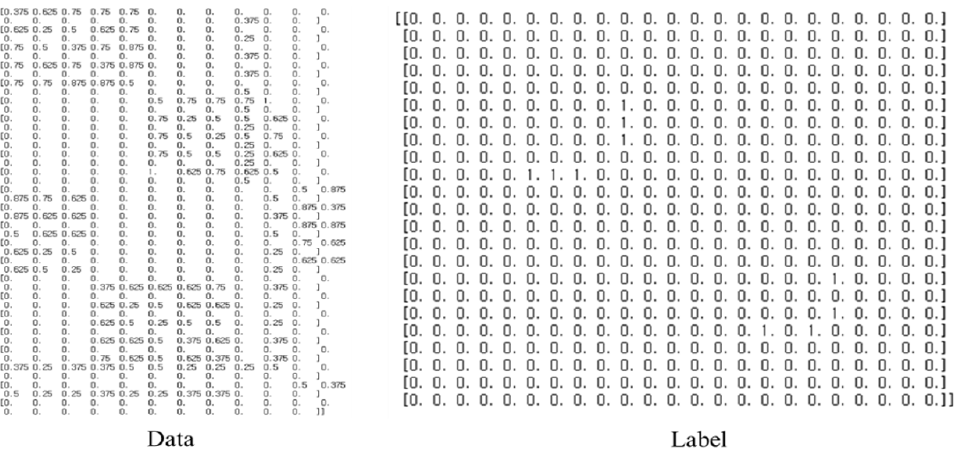
Figure 2. Example of data instance.